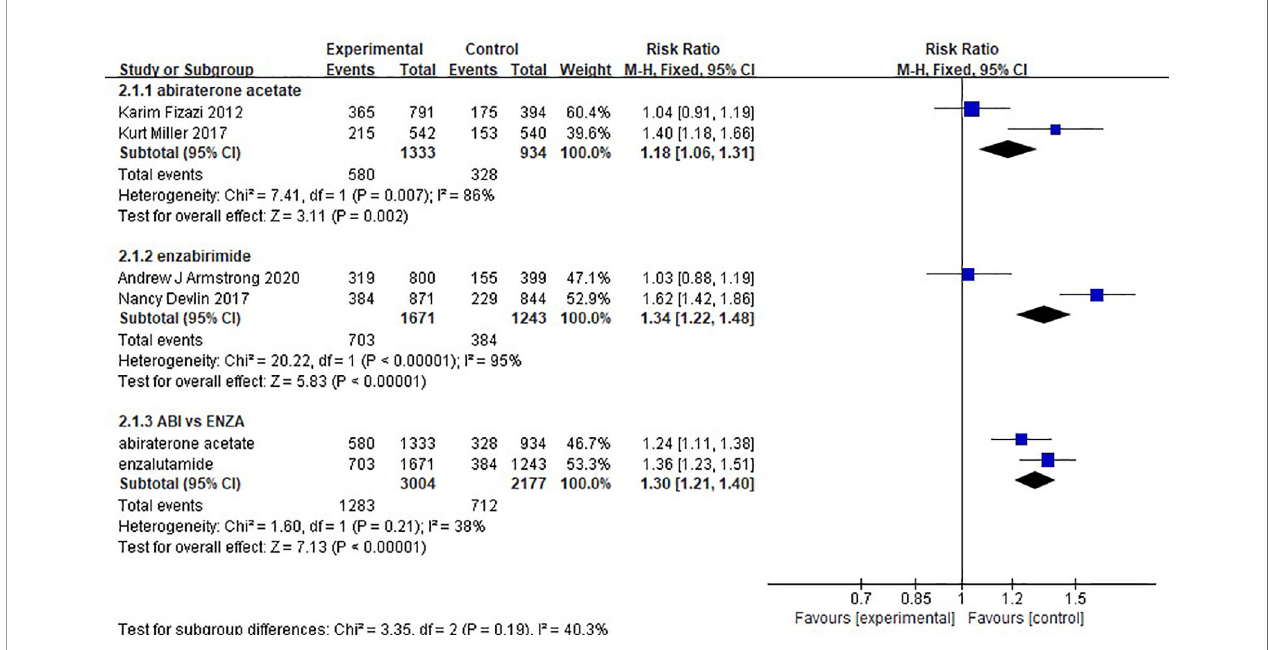
FIGURE 7 | Forest plots for serious adverse events in